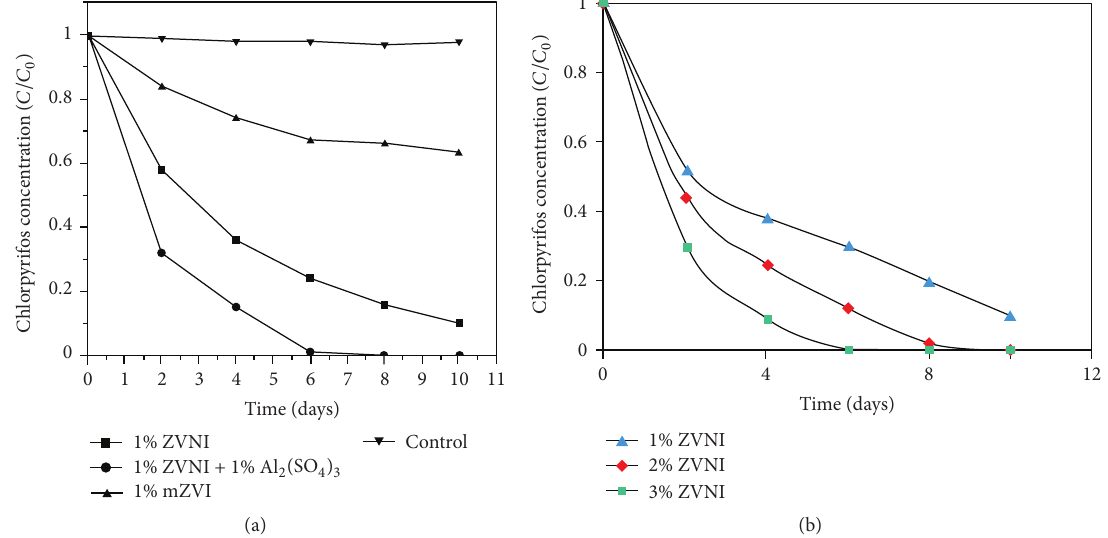
F 3: (a) Time-course degradation of chlorpyrifos with ZVNI. (b) Effect of ZVNI concentration on chlorpyrifos